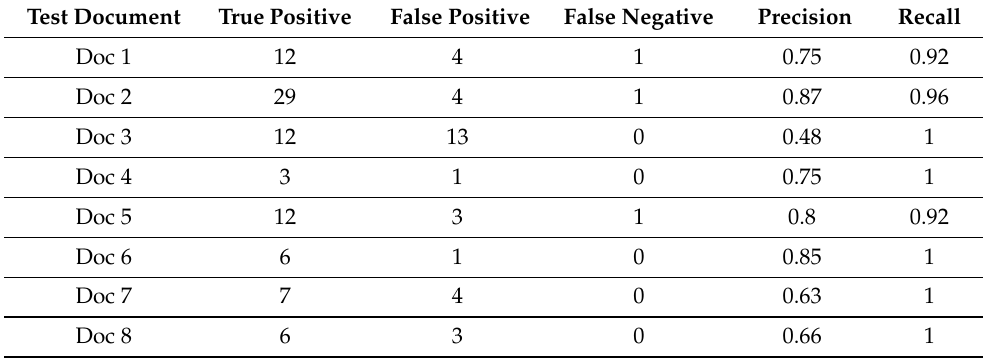
Table 2. Performance of the proposed framework using SVM classifier.